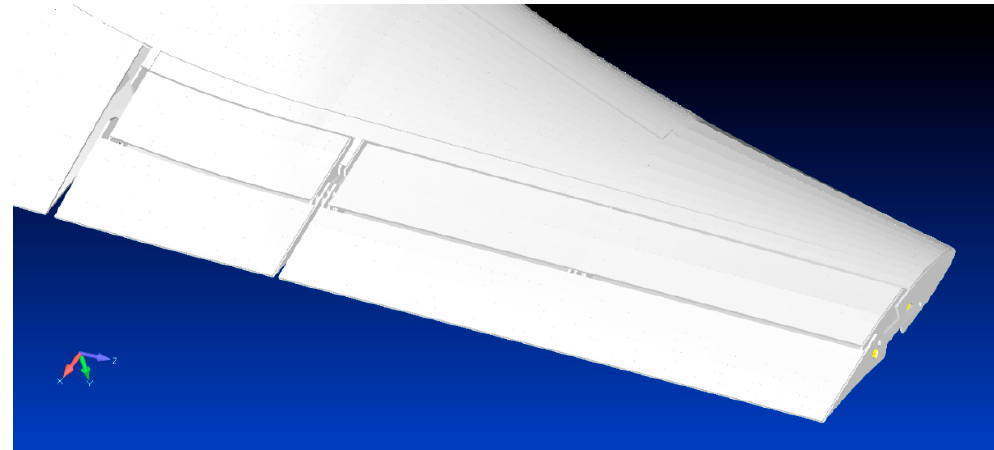
Figure 4. Detail of the morphing winglet trailing edges, [18].